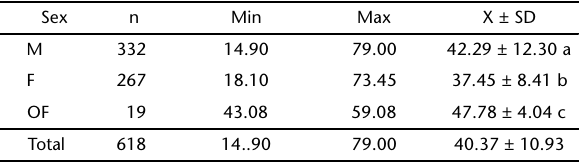
Figure 4. Size-frequency distribution of individuals (juveniles in- cluded) of Callinectes ornatus caught in the Estuary-Bay Complex of São Vicente. (OF) Ovigerous females, (F) females, (M) males, (CW) carapace width Table III. Number of individuals and size range (carapace width) of Callinectes ornatus . (n) Number of individuals, (Min) minimum, (Max) maximum, (X) mean, (SD) standard deviation, (M) males, (F) non-ovigerous females, (OF) ovigerous females (OF). Means followed by the same lower-case letter did not show significant differences (p > 0.05).